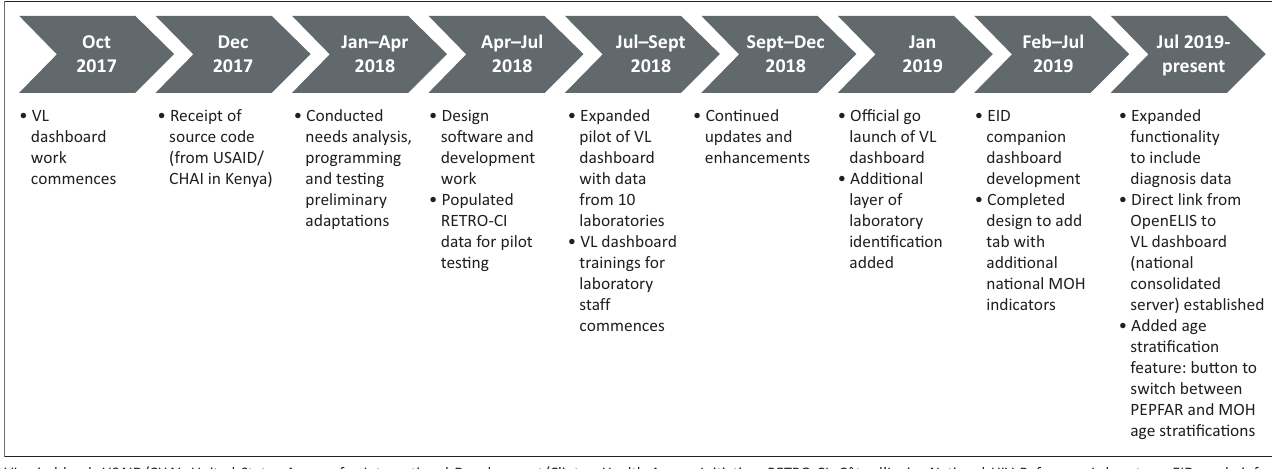
FIGURE 2: Timeline of viral load dashboard development. The development of the viral load dashboard began in October 2017 and a pilot version was completed in July 2018. Following adjustments to the software code the dashboard was finalised in January 2019 and is now populating data from all viral load testing laboratories.